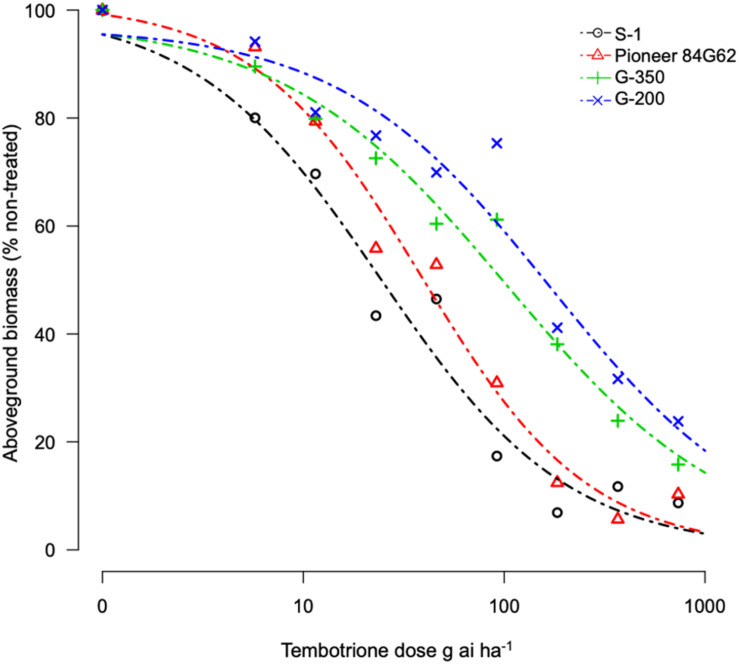
Tembotrione dose-response curves obtained by non-linear regression analysis of above-ground dry biomass of S-1 (susceptible), Pioneer 84G62 (commercial hybrid), G-200, and G-350 (resistant) using the three-parameter log-logistic model.